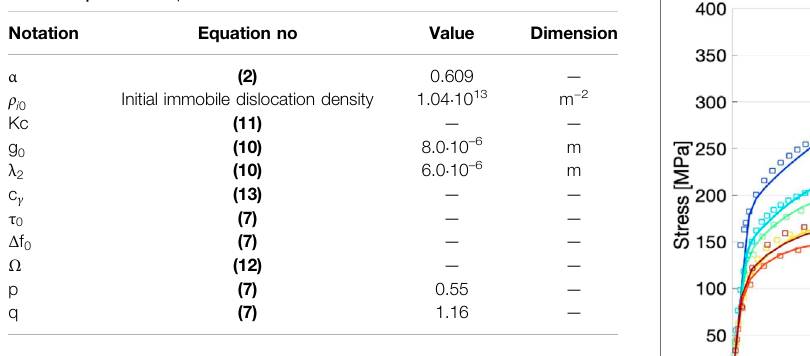
TABLE 2 | Calibrated parameters of the model.